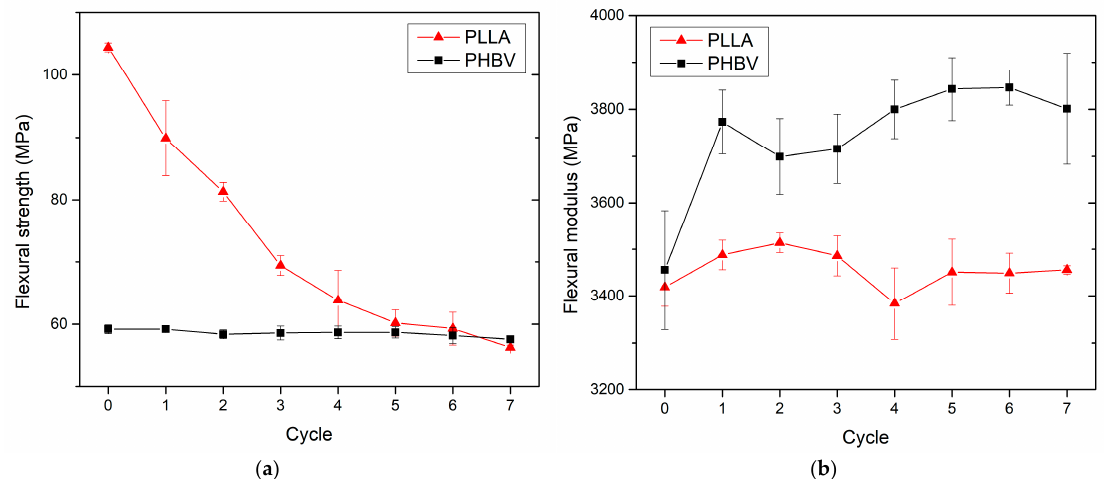
Figure 11. PLLA and PHBV flexural properties as a function of recycled cycle: ( a ) flexural strength; ( b ) flexural modulus.